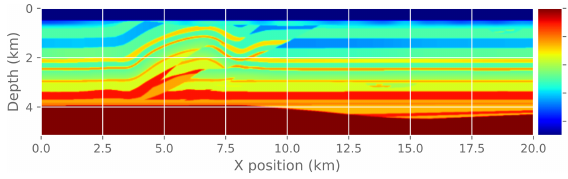
Figure 14. True model used for FWI.